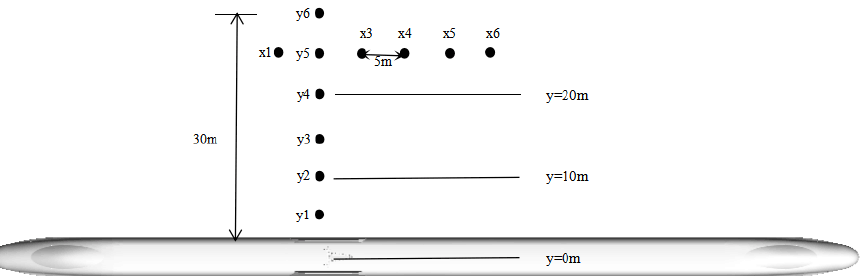
Figure 4. Locations of aerodynamic noise